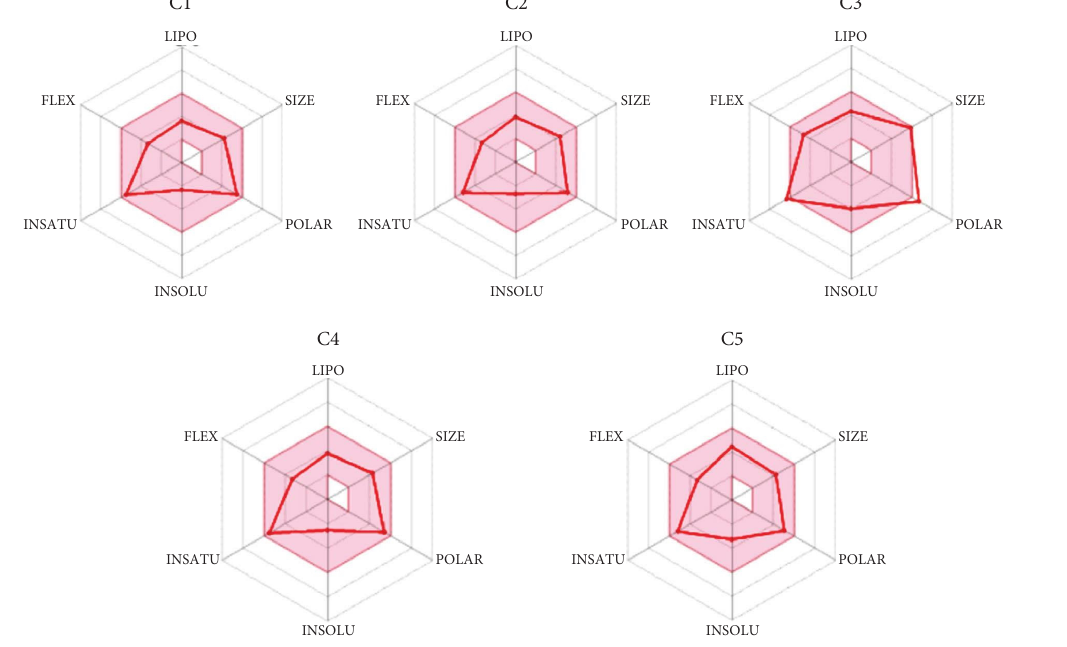
Figure 1: Physicochemical properties radar chart of C1 – C5 . Table 3: Lipophilicity and water solubility of TZDs ( C1 – C5 ) derivatives.